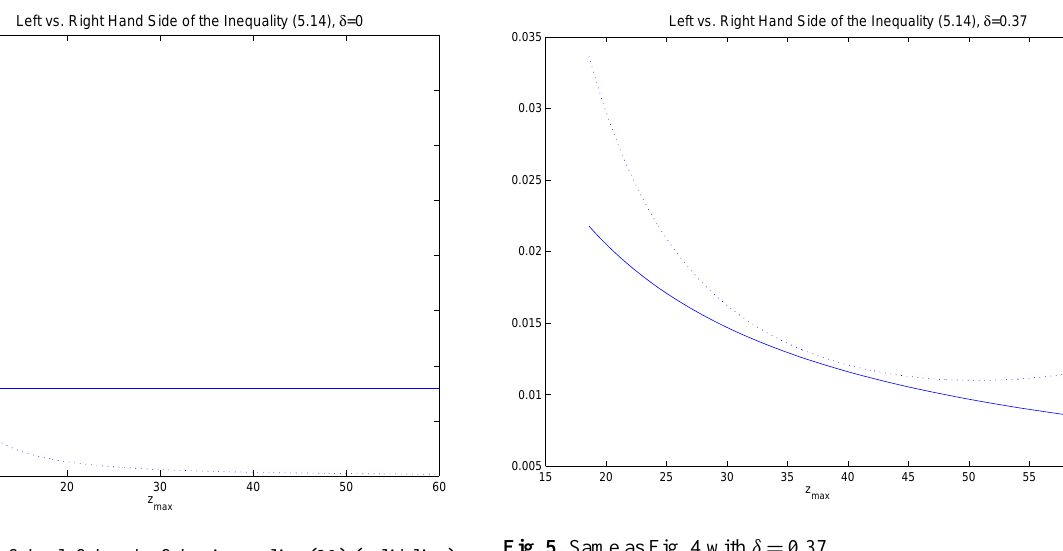
Fig. 5. Same as Fig. 4 with δ = 0 .